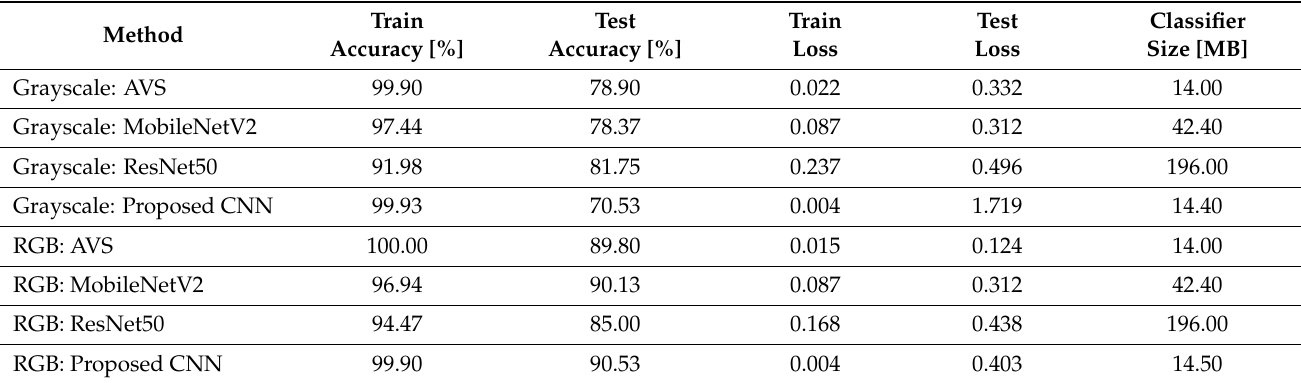
Figure 18. Confusion matrixes for test set of grayscale ( a ) and RGB ( b ) images for ResNet50. Table 3. 2D CNN classi fi ers comparison.